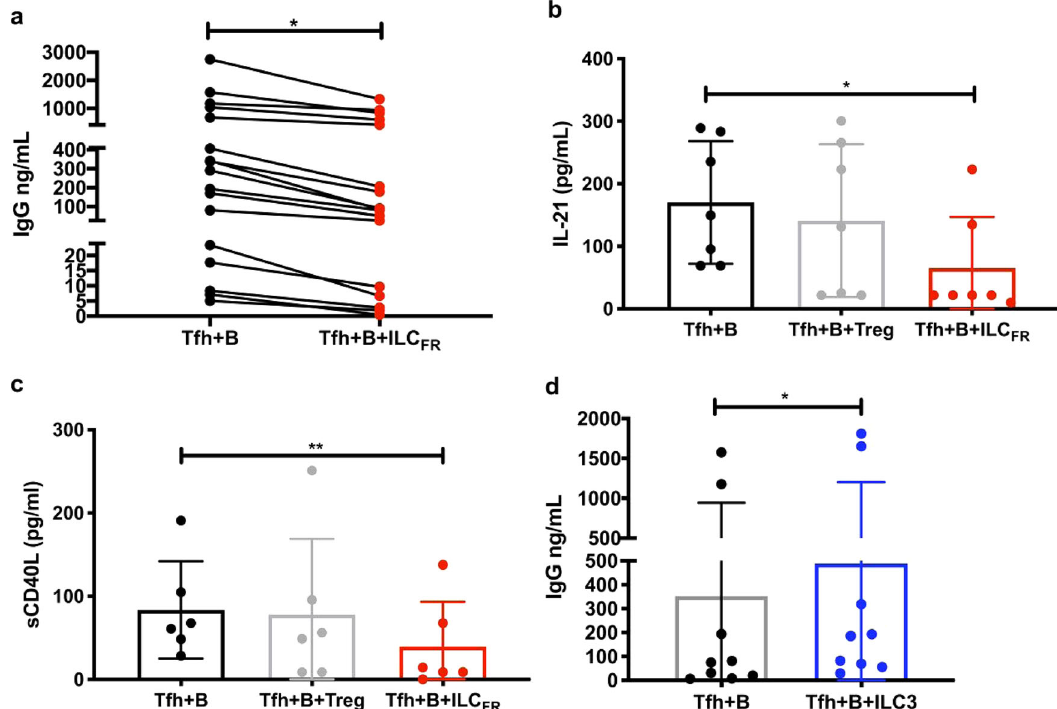
Fig. 4 ILC FR and ILC3s modify the GC-B and GC-Tfh interaction. a Production of IgG in the supernatants of 5-day co-culture of 30,000 GC-Tfh with 30,000 autologous GC-B cells plus or minus addition of 1000 ILC FR in the presence of 100 ng/mL SEB superantigen measured by ELISA ( n = 17 biologically independent tonsils per group, 5 independent experiments) (Paired, two-tailed parametric t -test; * p = 0.011; t = 2.899, df = 16, 95% CI ( − 432.2 to − 67.08), Mean ± SD). b Production of IL-21 or c sCD40L analyzed by 28 plex Luminex. ( n = 6 – 7 tonsils per group, 3 independent experiments) (Ordinary one-way ANOVA with multiple comparisons; IL-21: F = 3.542; * p < 0.0467; Mean± SD), sCD40L: F = 6.081; ** p < 0.0014; Mean ± SD). In d the graph shows IgG production in the supernatants of 5-day co-culture of 30,000 GC-Tfh with 30,000 autologous GC-B cells plus or minus addition of 3000 ILC3 in the presence of 100 ng/mL SEB superantigen measured by ELISA ( n = 8 biologically independent tonsils per group, 4 independent experiments) (Paired, two-tailed parametric t -test; * p = 0.018; df = 7, t = 3.09, 95% CI: (9.47 to 71.15), Mean±